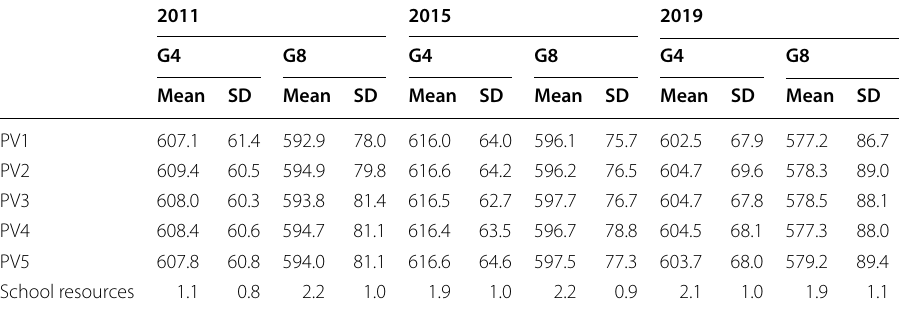
Table 3 Descriptive analysis of mathematics achievement and school resources availability for TIMSS 2011 to